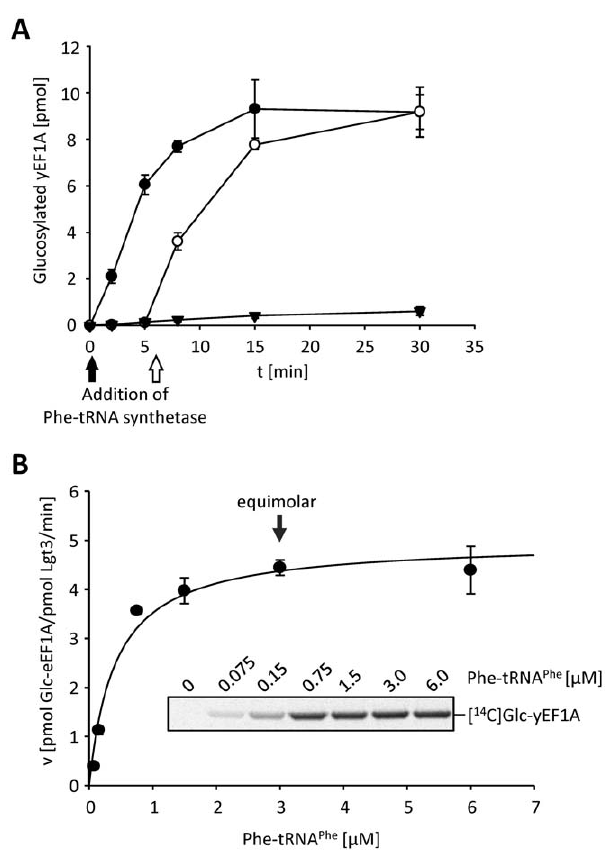
Figure 3. Aa-tRNA stimulates eEF1A glucosylation. (A) Time courses of the glucosylation of yeast eEF1A (yEF1A) with Lgt3 were performed in the presence of yeast tRNA (10 m M) and 10 m M UDP- [ 14 C]glucose (triangles). Phe-tRNA synthetase was added at time point zero (black circles) or after 6 min (open circles) as marked by corresponding arrows. 14 C-glucosylation of yEF1A was determined by SDS-PAGE and autoradiography. Shown curves represent means ( 6 SD) of three independent experiments. (B) Glucosylation of yEF1A (3 m M) by Lgt3 (5 nM) was conducted with increasing concentrations of HPLC- purified [ 14 C]Phe-tRNA Phe . Initial glucosylation rates were determined after incubation for 10 min at 30 u C in the presence of 50 m M GTP c S, 10 mM PEP, 0.1 mg/ml pyruvate kinase and 10 m M UDP-[ 14 C]glucose as the donor substrate. Radiolabeled aa-tRNA could be distinguished from 14 C-glucosylated yEF1A by separation of the products by SDS-PAGE. Data shown represent velocities of yEF1A glucosylation and are given as means ( 6 SD) of three independent